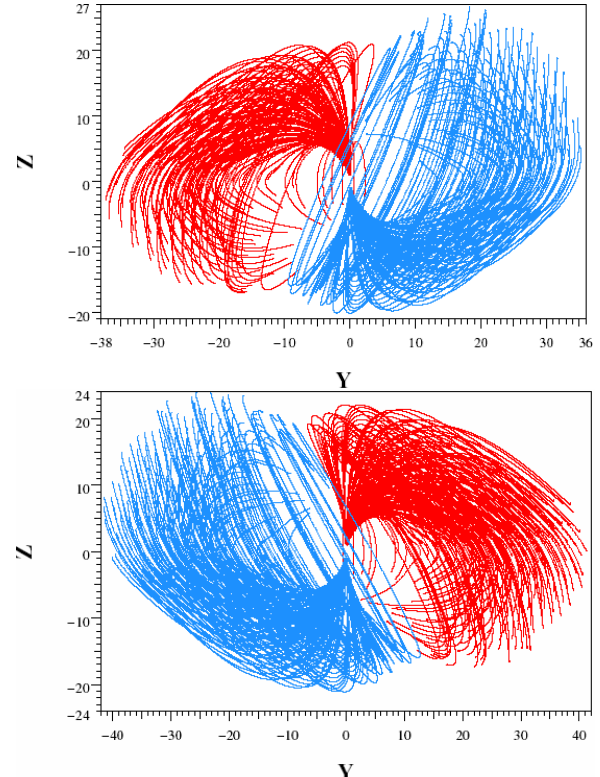
Figure 6 . View from the Sun to the open field line bundles. Upper panel: Case 1. The IMF components are: Bx =-10 nT, By =10 nT, and Bz =23 nT, the same as for Figure 4. The parts of the open field lines which are placed inside the magnetosphere are shown. Red field lines map from the magnetopause to the northern polar ionosphere, and blue field lines map from the southern polar ionosphere to the magnetopause. Outside the magnetopause (not shown) the red lines go from the Sun to the Earth and the blue lines go antisunward . Bottom panel: Case 2. Open field line bundles. All calculations are made for case 2: UT 15h Nov 8, 1998, when the IMF components, according to the shifted ACE data were Bx = -8.2 nT, By =-14 nT, Bz =22 nT. The solar wind plasma parameters, which were used in the model calculations, are: the density 15 cm -3 , and velocity 519 km/s for this case.